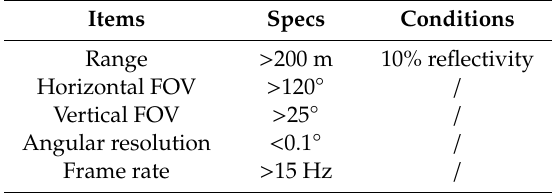
Table 2. Estimated specifications of LiDAR for Level 4 and 5 autonomous